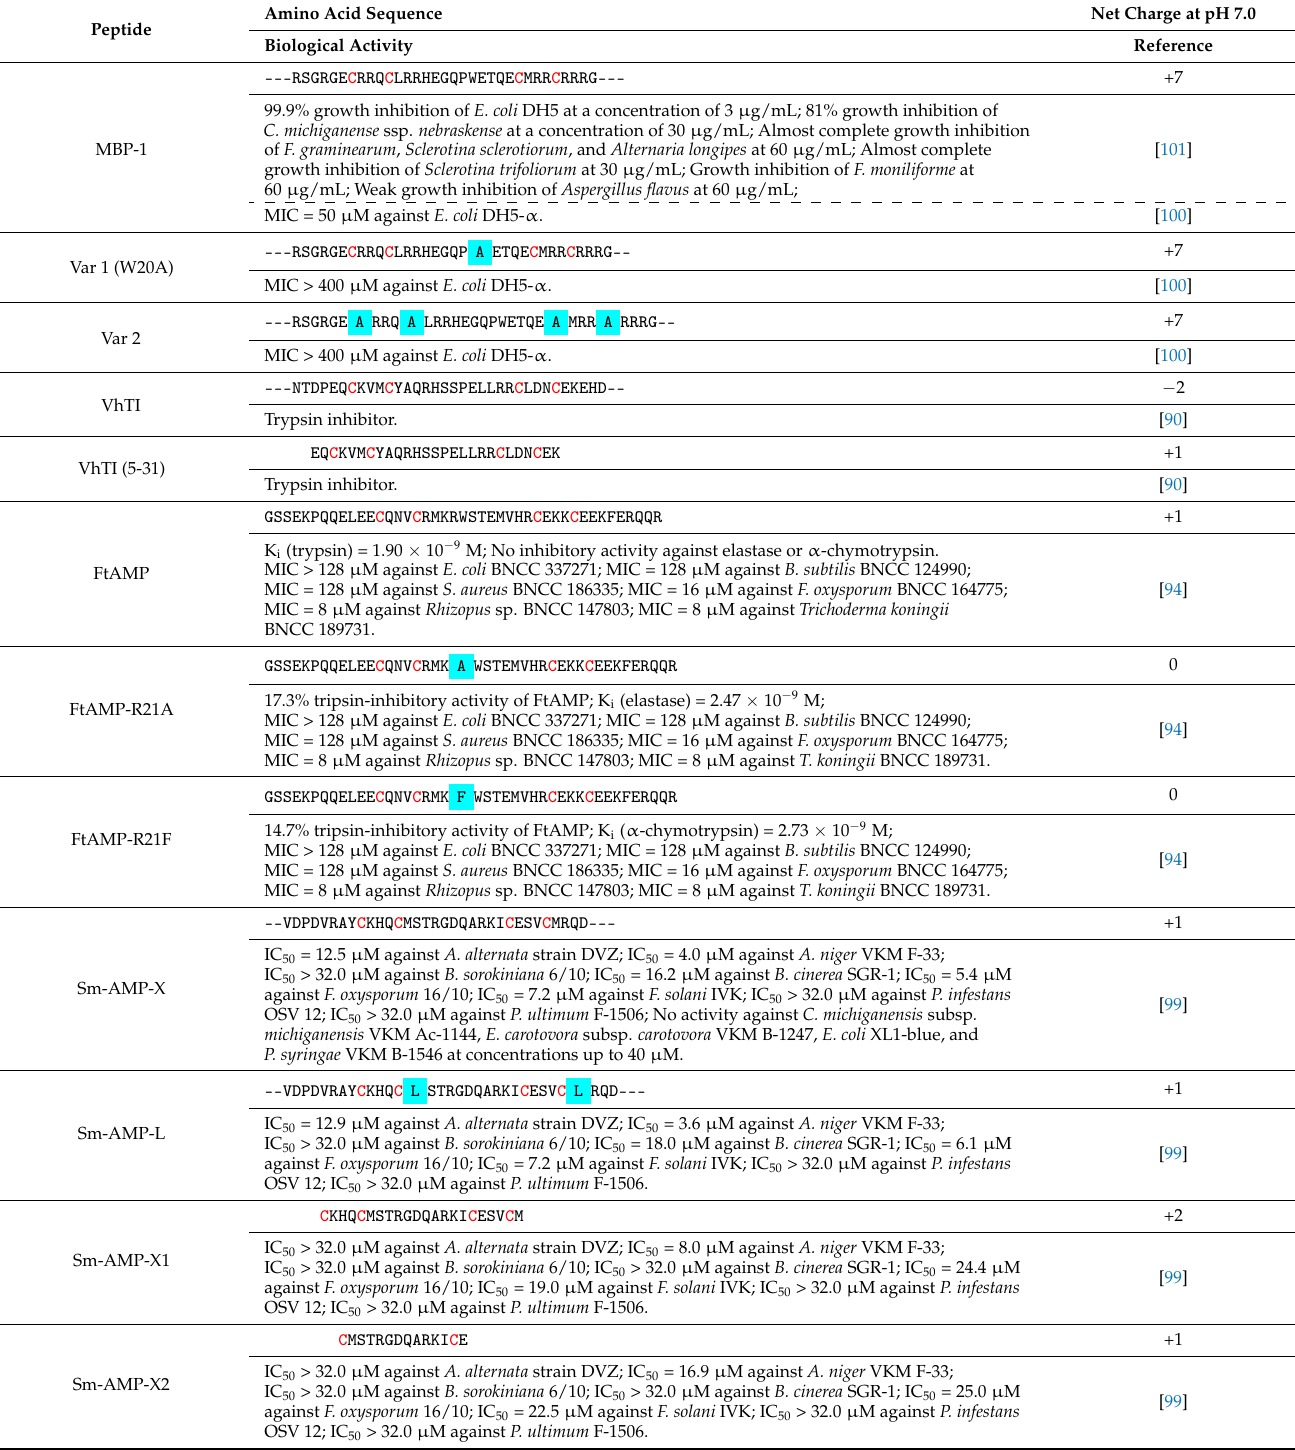
Table 3. The α -hairpinins and derived peptides: sequence, net charge at pH 7.0, and biological activity. Cysteine residues are shown in red, and substituted amino acids are highlighted in cyan. Gaps ( − ) were introduced to improve the alignment. Note: O—hydroxyproline; *—both figures are given in the original